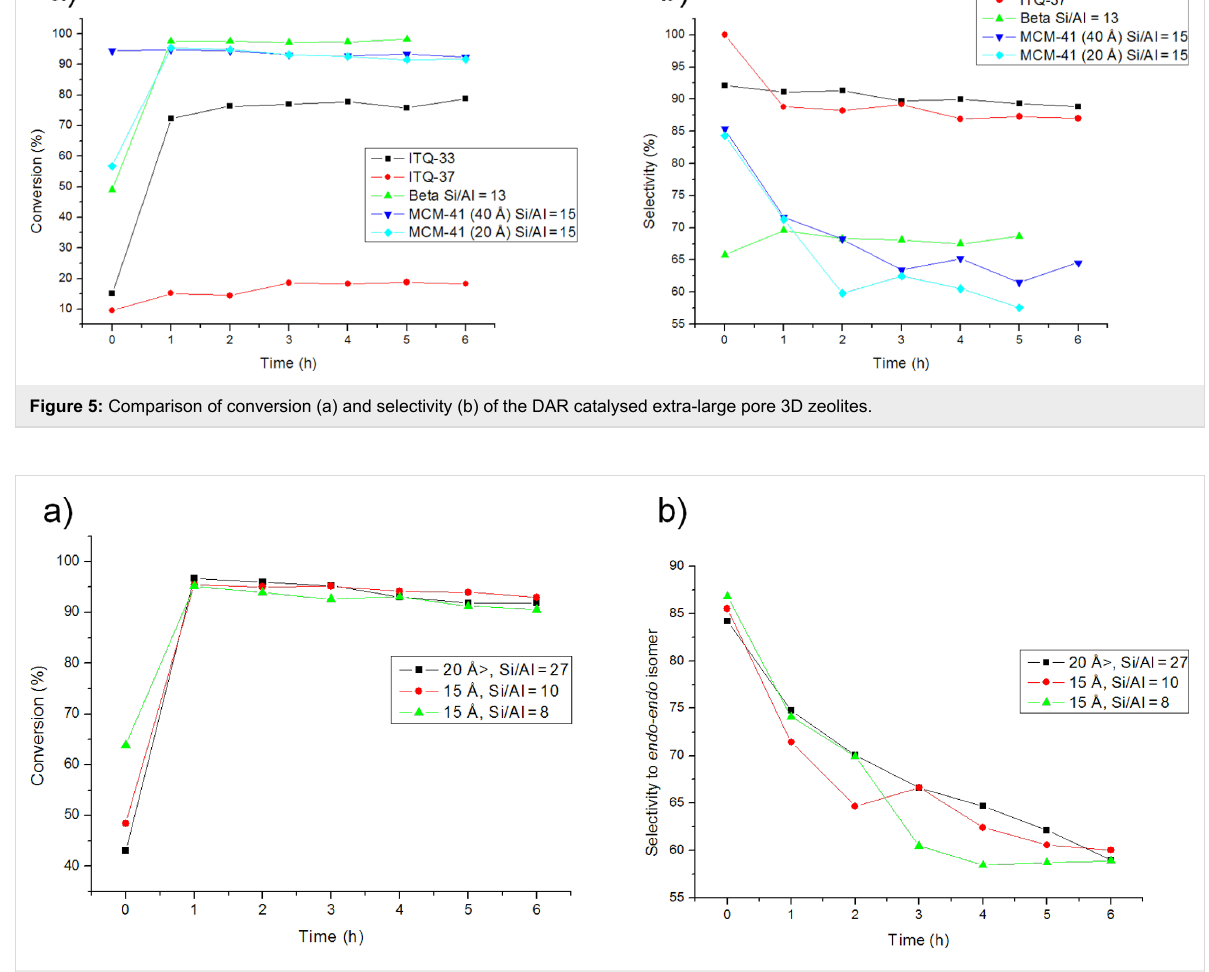
Figure 6: Effect of the Si/Al ratio in the conversion (a) and selectivity (b) of the DAR.